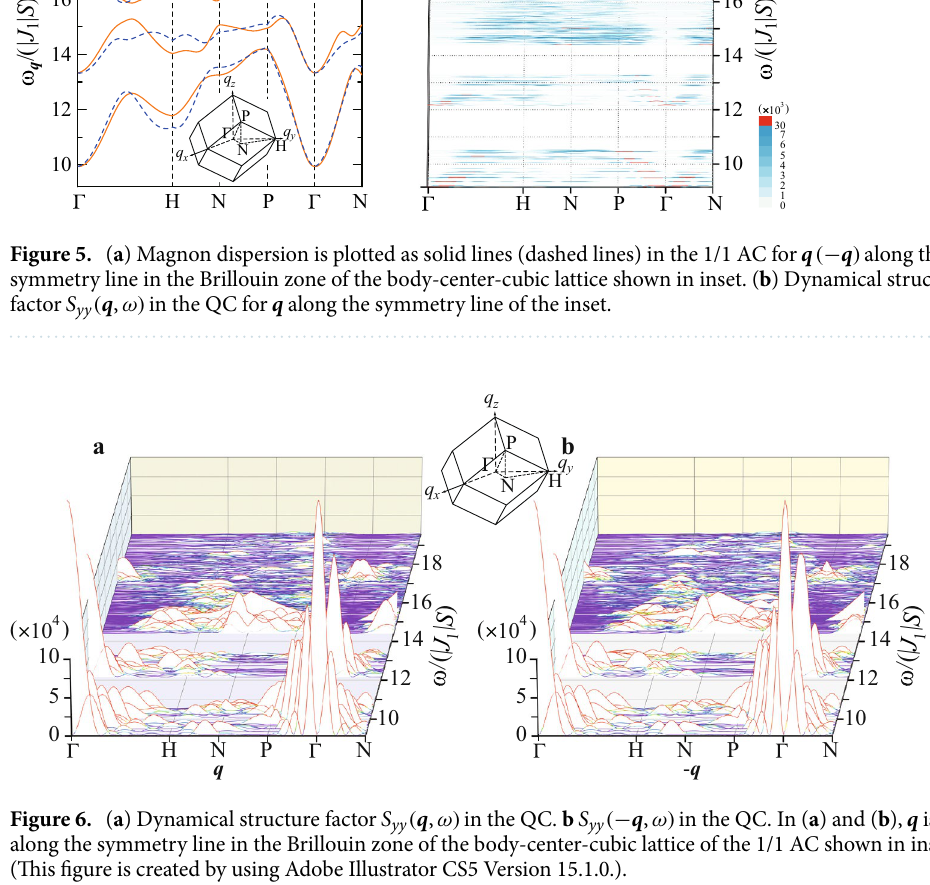
Figure 6. ( a ) Dynamical structure factor S yy ( q , ω) in the QC. b S yy ( along the symmetry line in the Brillouin zone of the body-center-cubic lattice of the 1/1 AC shown in inset. (This figure is created by using Adobe Illustrator CS5 Version